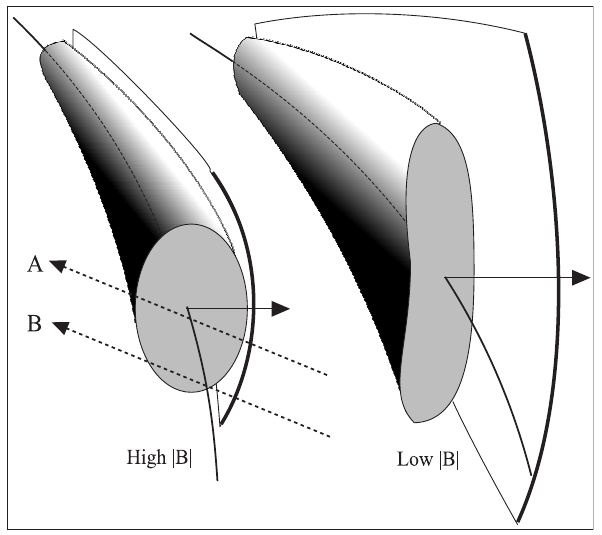
Fig. 8. A representation of possible ICME cross sections at 1AU for high | B | and low | B | events. In the former case the string field leads to the ICME maintaining an approximately circular cross sec- tion, while for a weaker field, the ICME becomes elongated in the vertical direction in this sketch. The arrow denotes the direction of ICME motion, the curved line ahead of the ICME corresponds to a possible bow shock location and the solid line coming out of the body of the CME corresponds to a schematic axis of the ICME. Two possible spacecraft crossings are shown for the high | B | picture: A passing close to the central axis, and B clipping the outer edge of the